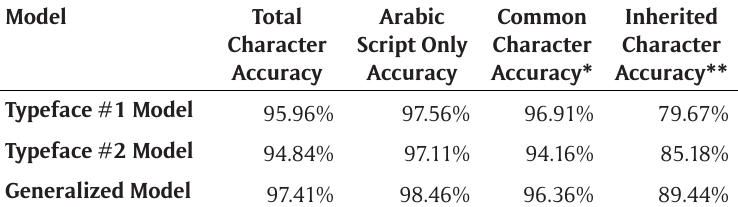
Table 2: Overview of OCR accuracy rates (drawn from character error rate (CER)